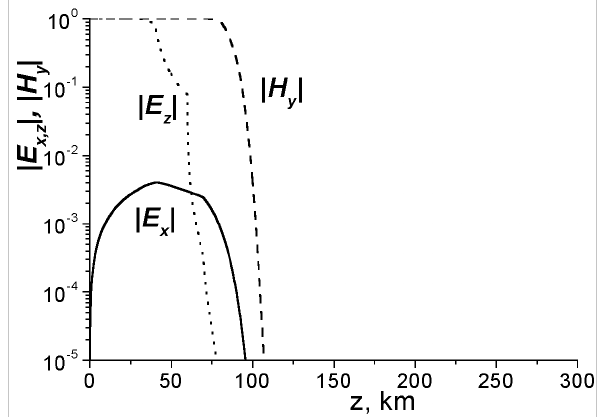
Fig. 5. A dependence of components | E x,y,z | and | H x,y | on the vertical coordinate z in the absence of geomagnetic field H 0 =0 (daytime, normal solar Fig.5. A dependence of components |E x,y,z | and |H x,y | on the vertical coordinate z in the Fig.3. Vertical dependencies of the absolute values of components of complex tensor of absence of geomagnetic field H 0 = 0 (daytime, normal solar activity). dielectric permittivity of atmosphere and ionosphere at w = 50 s -1 used in simulations (daytime, normal solar activity) (a). The detailed dependence for the heights 70 ‚ 110 km (b).